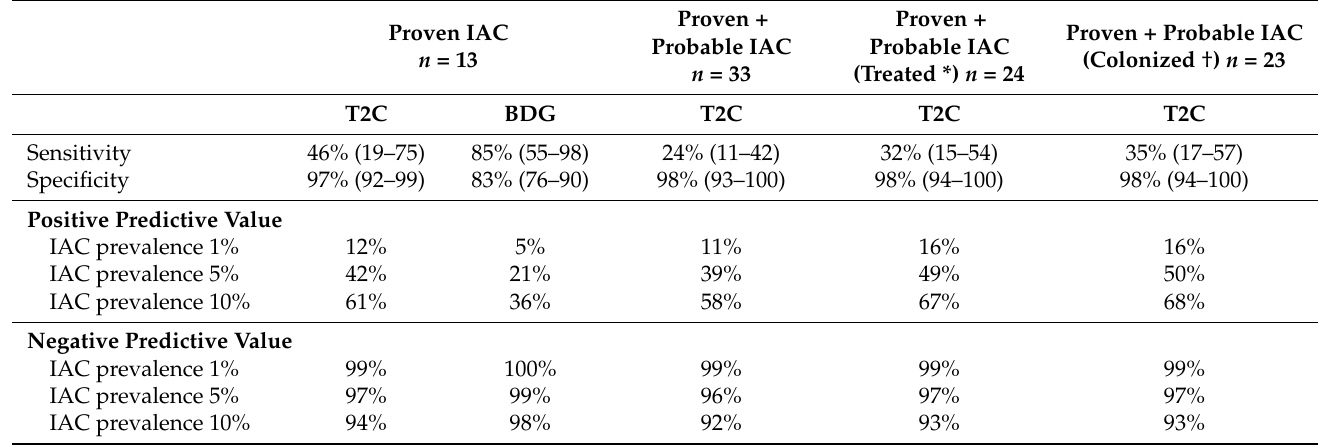
Table 4. Diagnostic performances of T2C and